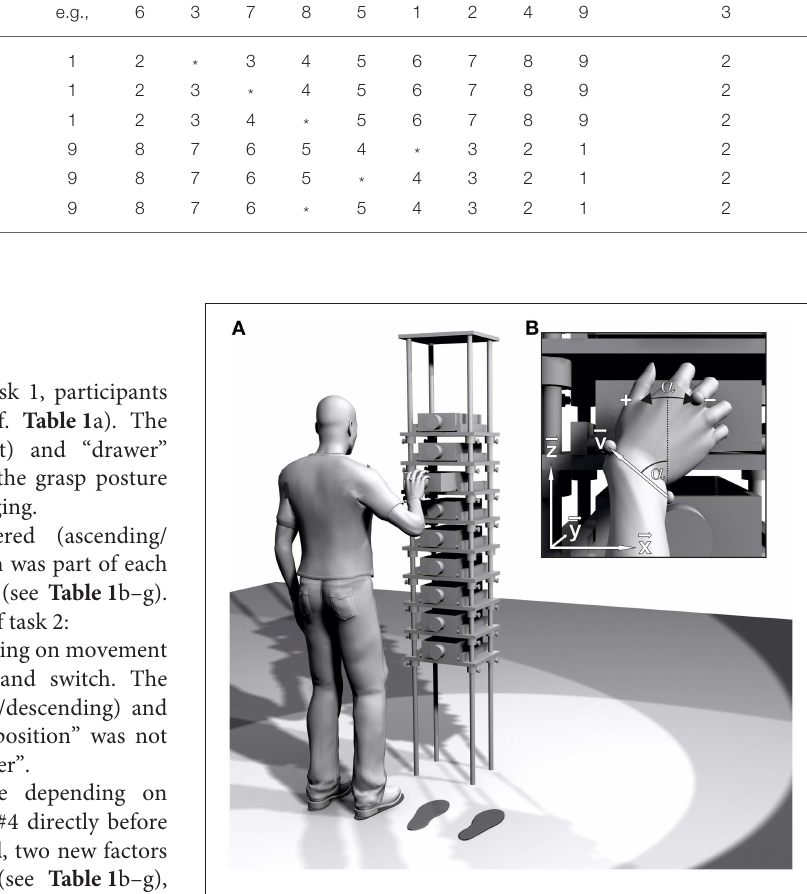
was placed on each shelf, with a number from 1 (lowest) to 9 (highest) inscribed on the left side. A stop mechanism allowed drawer front, a cylindrical plastic knob with a diameter of 7 cm and a depth of 4 cm was